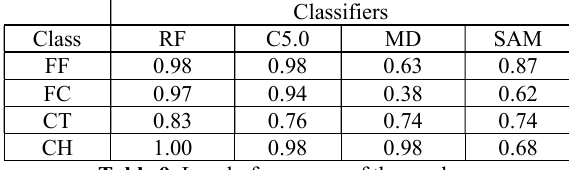
Table 9 . Level of accuracy of the